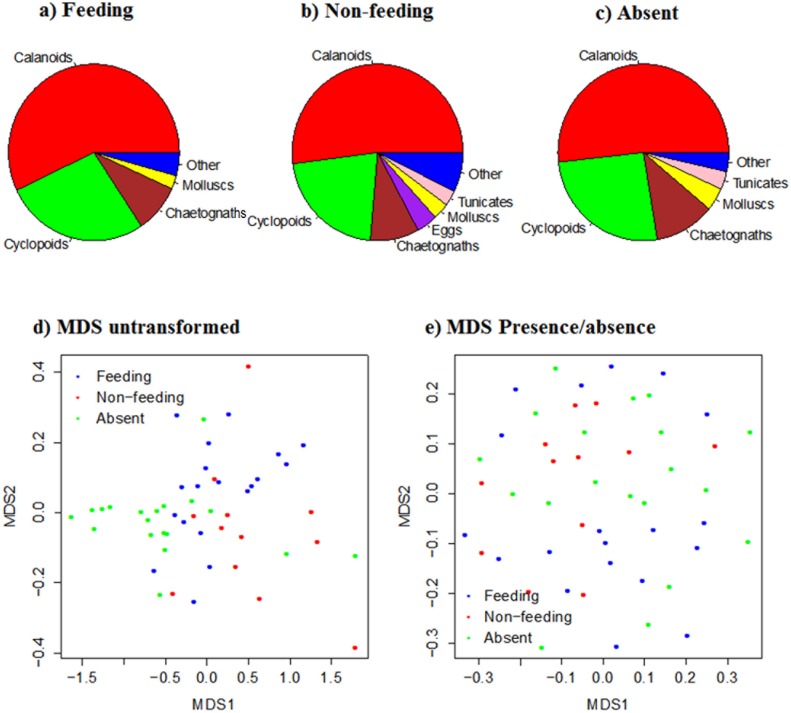
Zooplankton composition and manta ray foraging behaviour.Zooplankton composition at Lady Elliot Island in relation to reef manta ray behaviour showing little differences in composition: a) Feeding (n = 17), b) Non-feeding (n = 12), and c) Absent (n = 21). Nonmetric multidimensional scaling analysis of the community: d) with no transformation, and e) after a presence-absence transformation (n = 50).